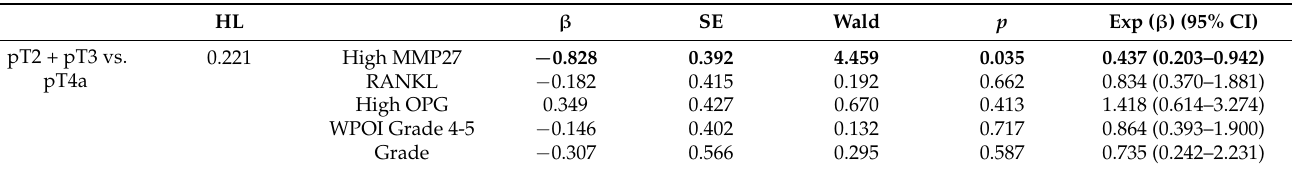
Table 2. Binary logistic regression analysis of IHC markers, WPOI and histopathological grading in relation to T-stage. Significant results are highlighted in bold.